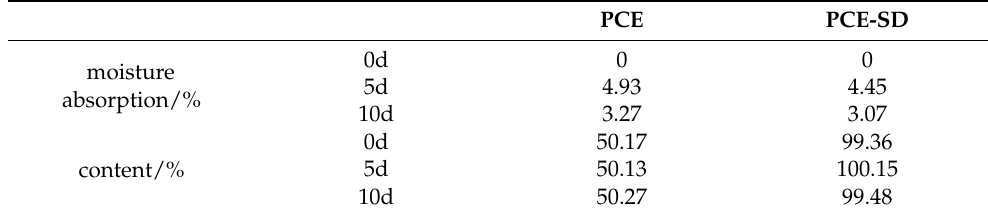
Table 5. The content and moisture absorption under high humidity (saturated NaCl solution, RH 70% ± 5%).